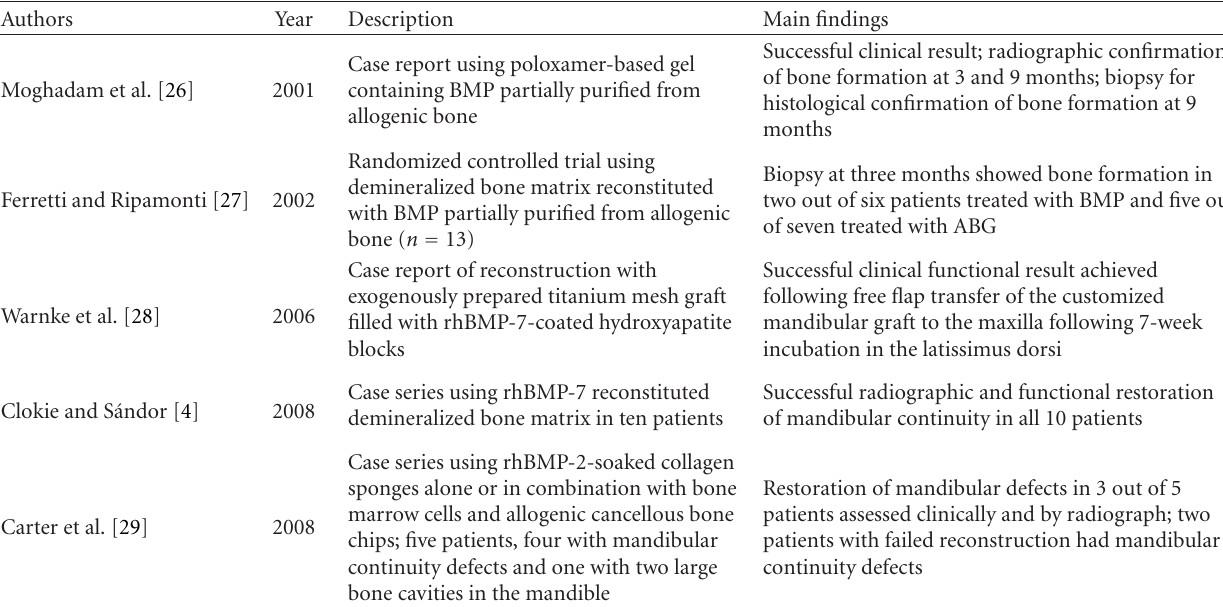
Table 2: Selected clinical studies using rhBMPs for human mandibular